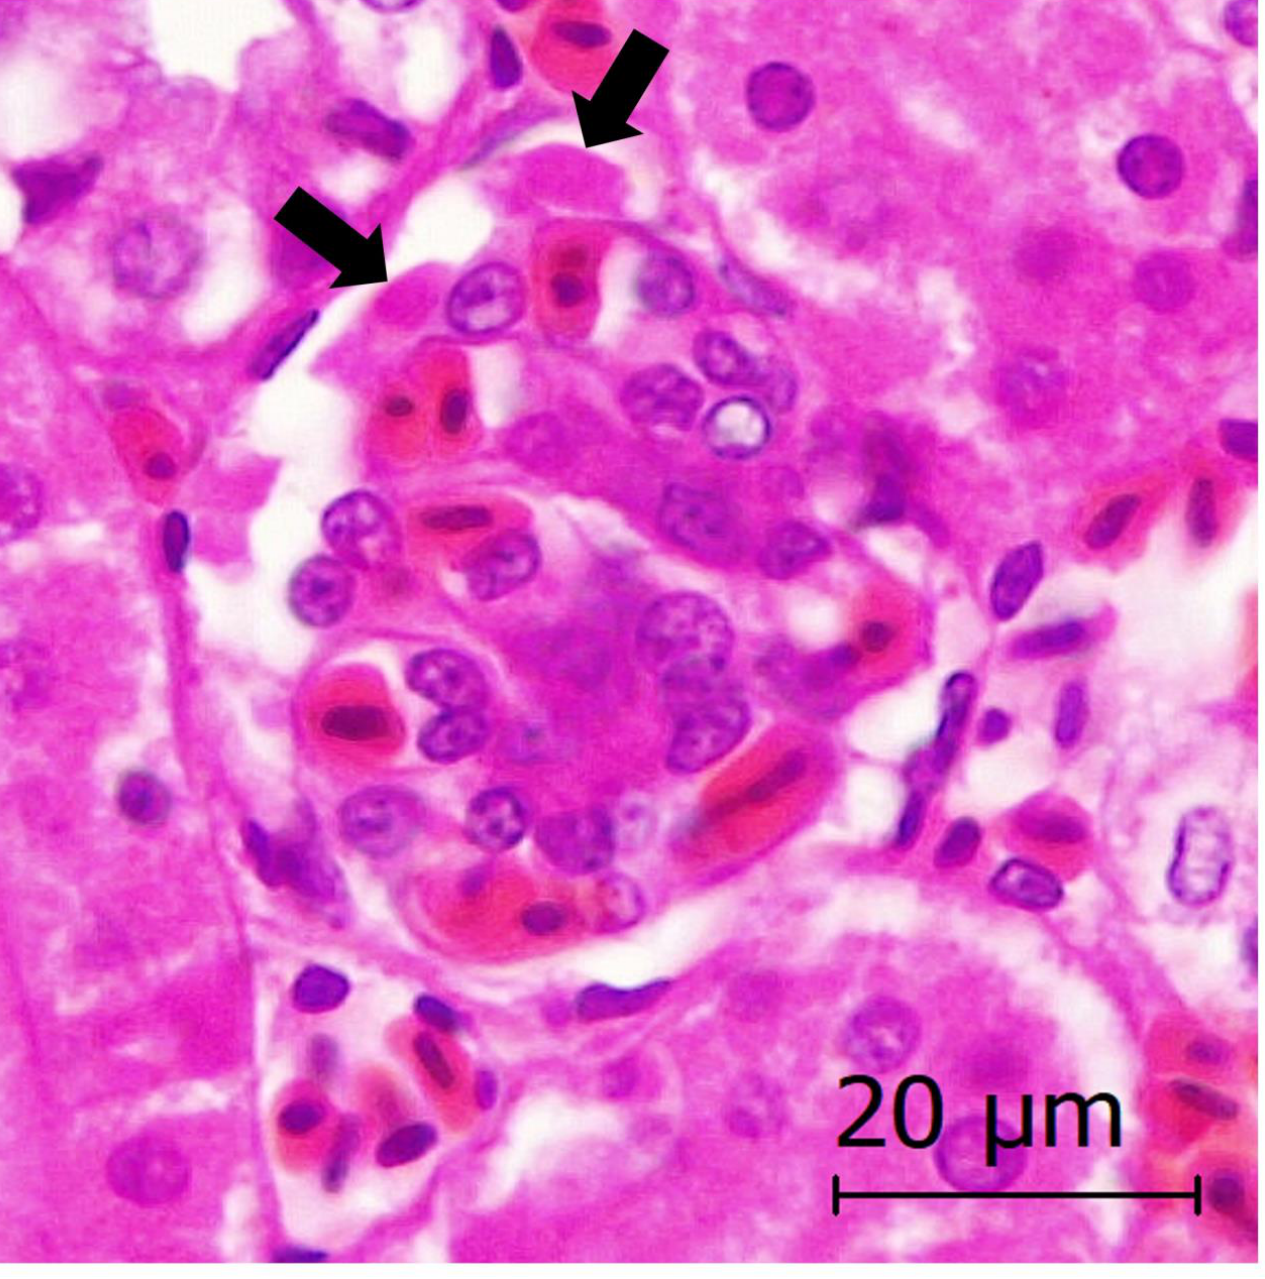
Figure 4. Stress-related neurogenic shock in a Cantabrian capercaillie. Disseminated intravascular coagulation-DIC (i.e., microthrombi, arrows) in a renal glomerulus is observed. Rupture of the Heart Apex and Cardiomyopathy Three captive capercaillies, one young and two adults, suddenly died due to a rupture of the heart apex (Figure 5). Hemopericardium was the main gross lesion observed. Micro- scopically, subacute cardiomyopathy was also diagnosed, comprising myodegeneration with fragmentation of myocardial fibers, flocculation of the necrotic sarcoplasm, mineral- ization with marked basophilic granularity, and a prominent infiltrate composed mainly of macrophages (Figure 5). A fourth capercaillie showed cardiomyopathy without rupture of the heart